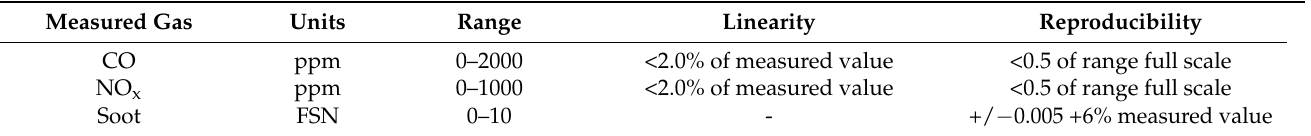
Table 4. Range and accuracy of exhaust gas measurement